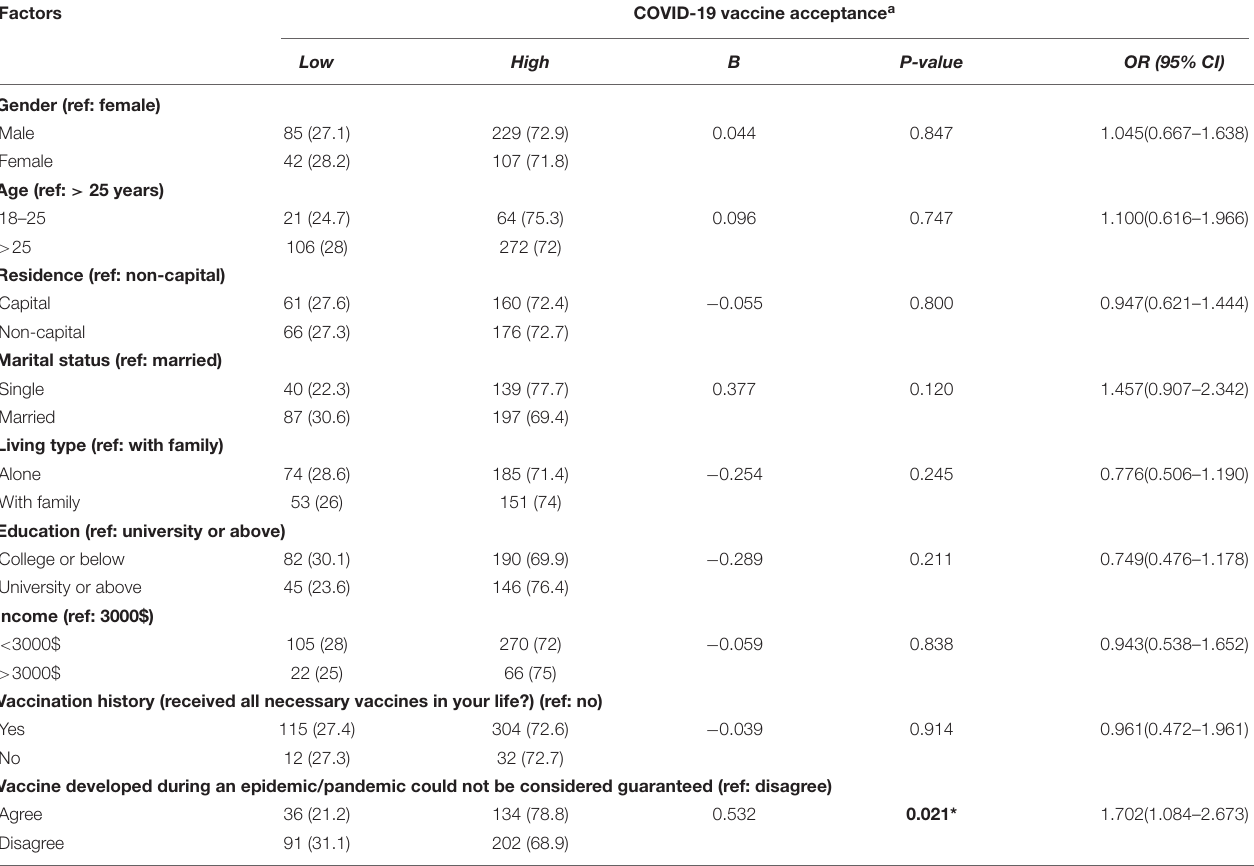
TABLE 3 | Logistic regression analysis with low and high acceptance toward COVID-19 vaccine. Factors COVID-19 vaccine acceptance a Low High